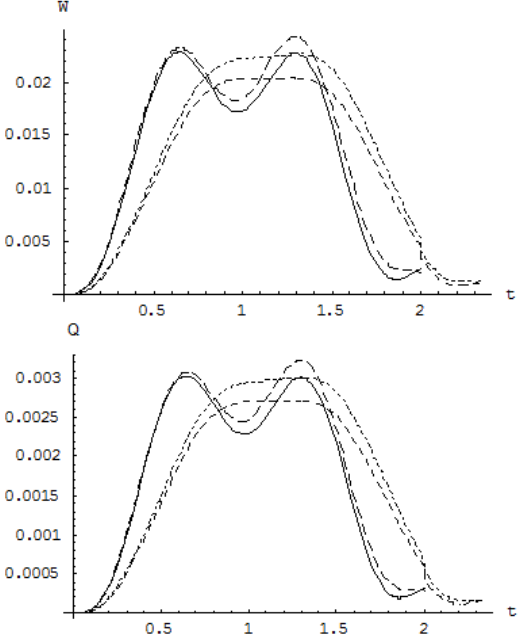
Figure 36: The vertical-torsional motion of the middle of the bridge, for R = 50 m, d = 5 m, e H = 3.00 m, e V = 1.20 m, υ = 30 m/s, un- der the action of a Damped load ( __ ), Simple load ( _ _ ), Damped vehicle (- - - ), Simple vehicle (. . . .).